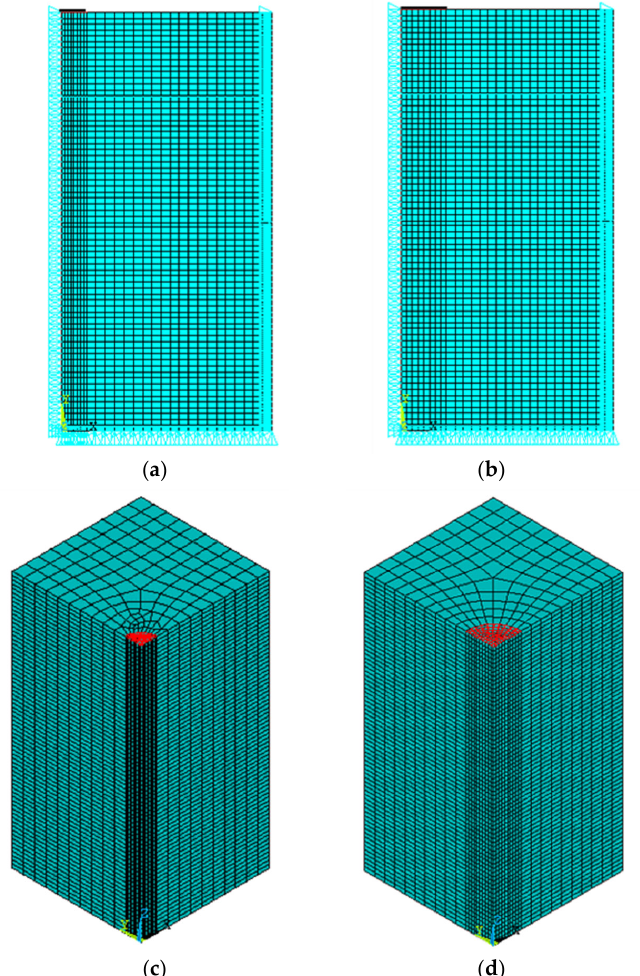
Figure 7. The geometry of FEM, meshing, and boundary conditions: ( a ) D = 85 mm 2DM; ( b ) D = 85 mm 2DM; ( c ) D = 85 mm 2DM; ( d ) D = 85 mm 2DM.